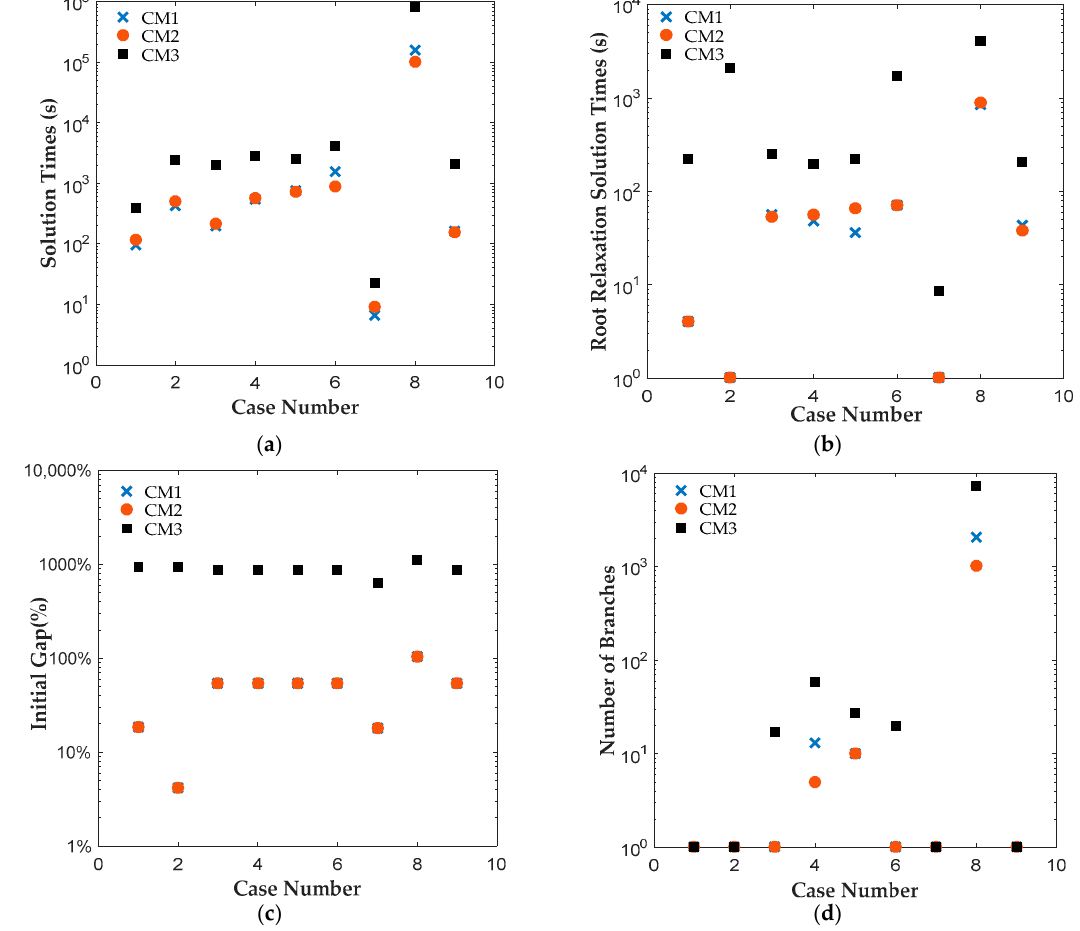
Figure 5. Comparison of ( a ) solution times, ( b ) root relaxation solution times, ( c ) initial gaps, and ( d ) number of branches for CM1, CM2 and CM3.